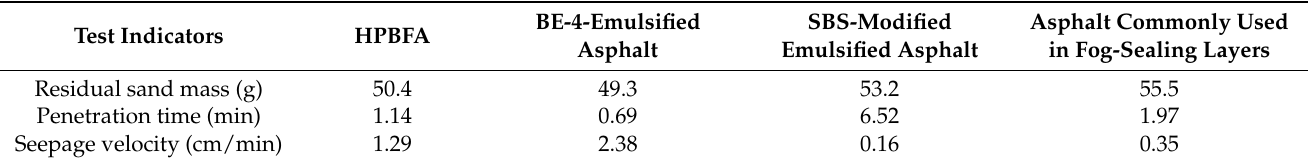
Table 6. Results of permeability tests of different fog-sealing adhesive materials.